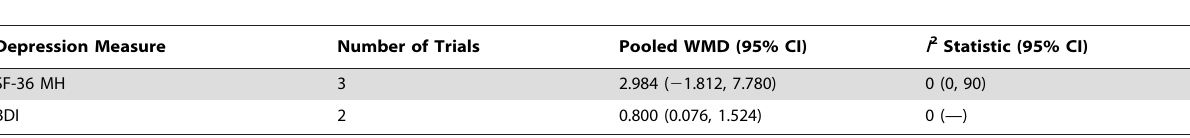
Table 6. Pooled weighted mean differences in depression score for MAD